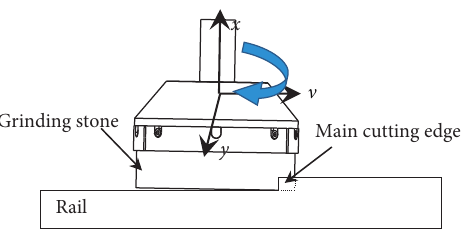
Figure 7: Schematic diagram of grinding mechanism of the grinding stone.